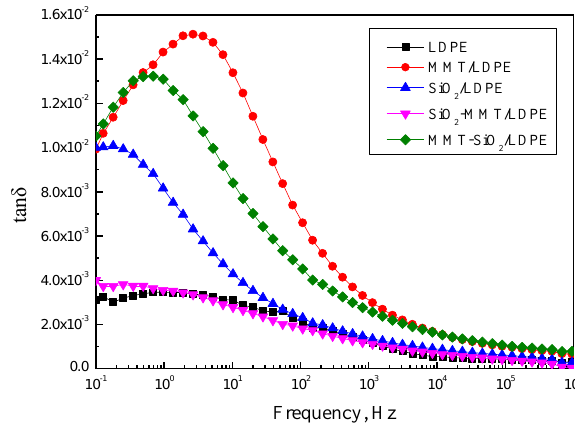
Figure 5. Curves of ε r with respect to f .